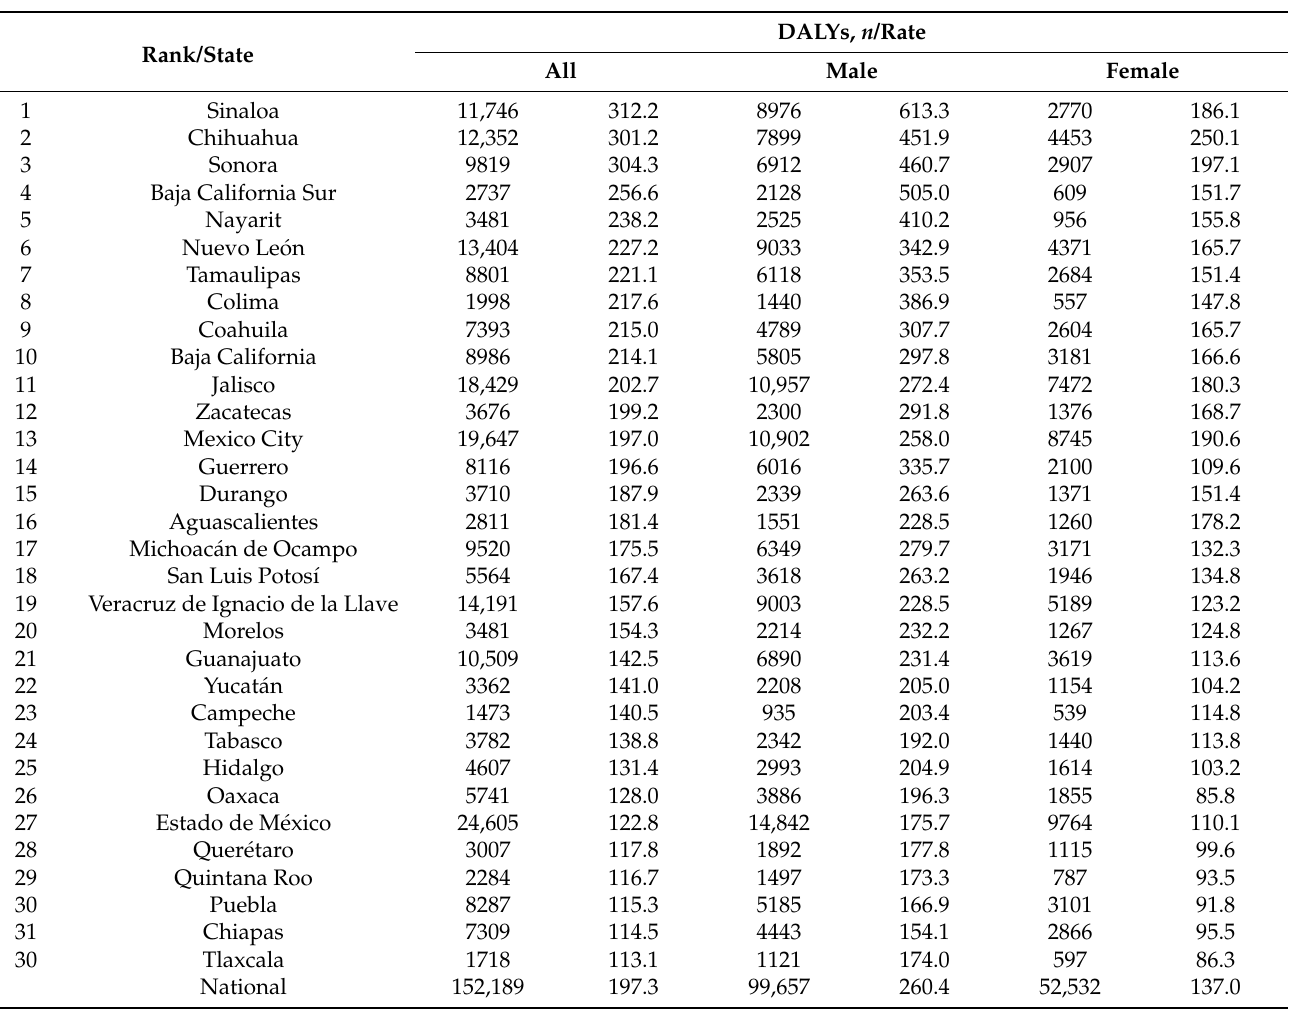
Table 1. Burden of tracheal, bronchus, and lung cancer in the states of Mexico,